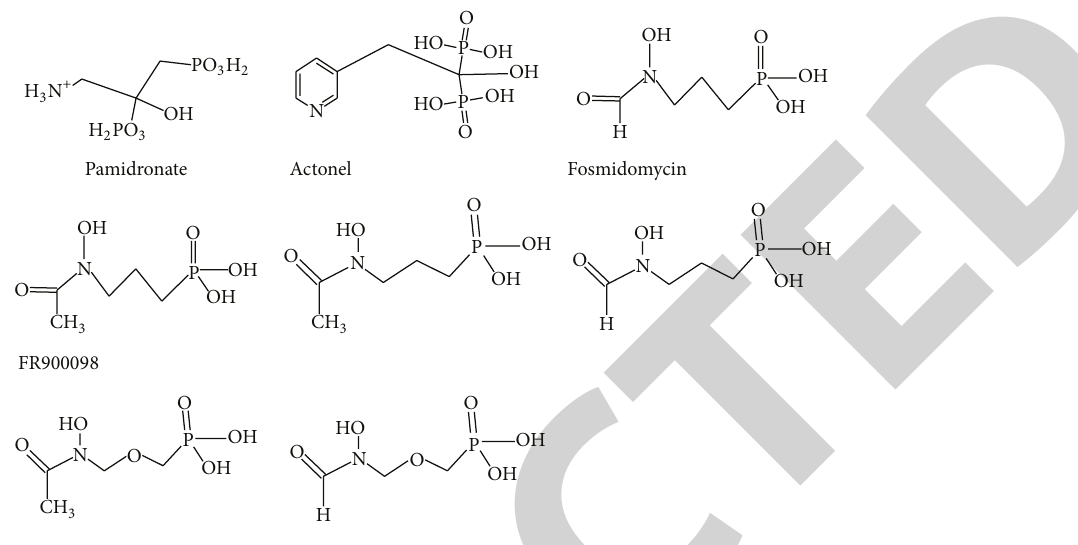
Figure 3: Structures of diphosphate and bisphosphonates (inhibitors of pathway) [8].